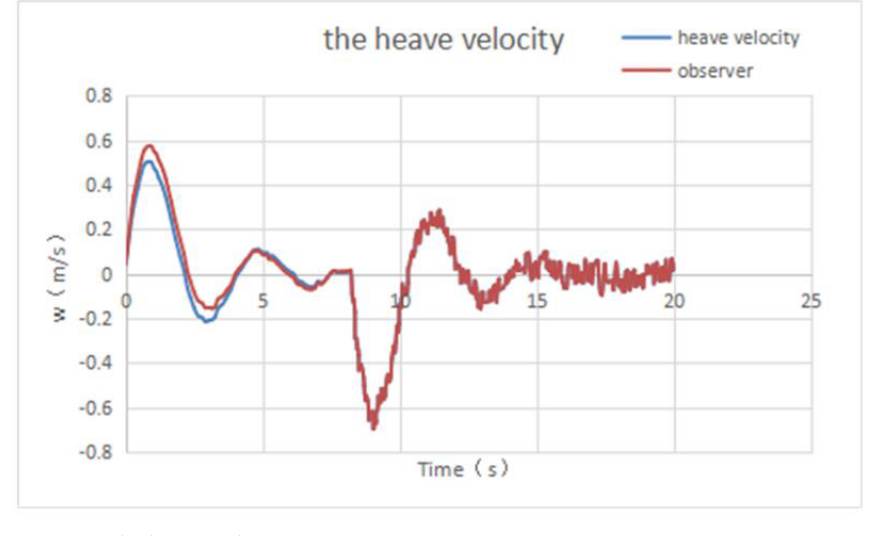
Figure 4. The heave velocity.